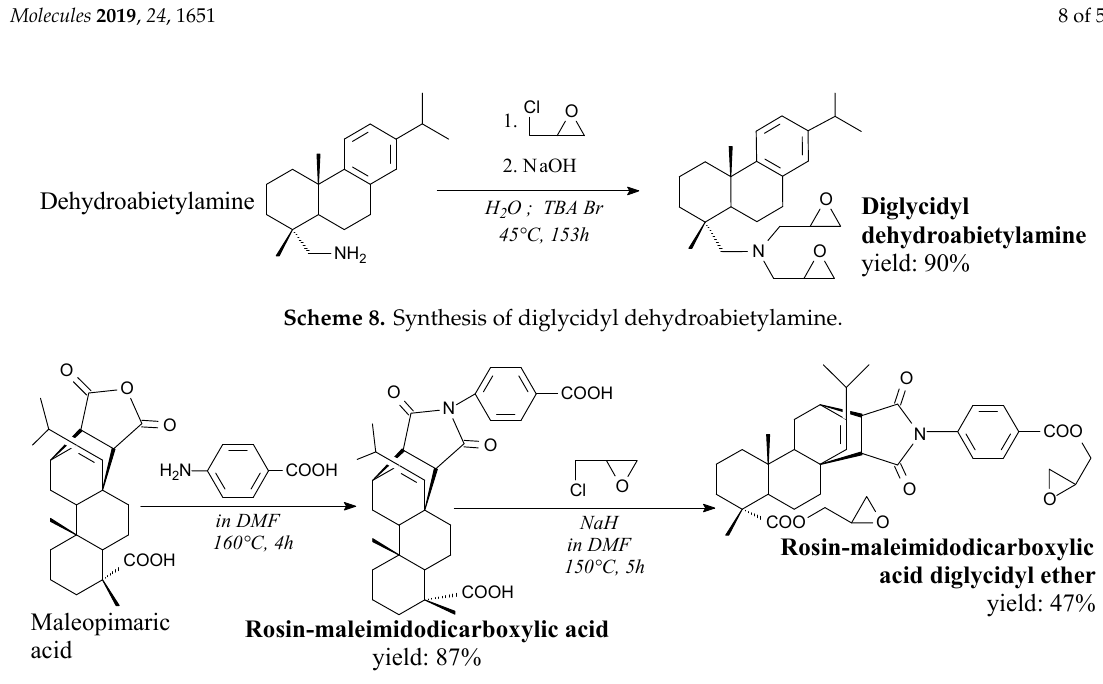
Scheme 9. Preparation of rosin maleimidodicarboxylic acid diglycidyl ether.